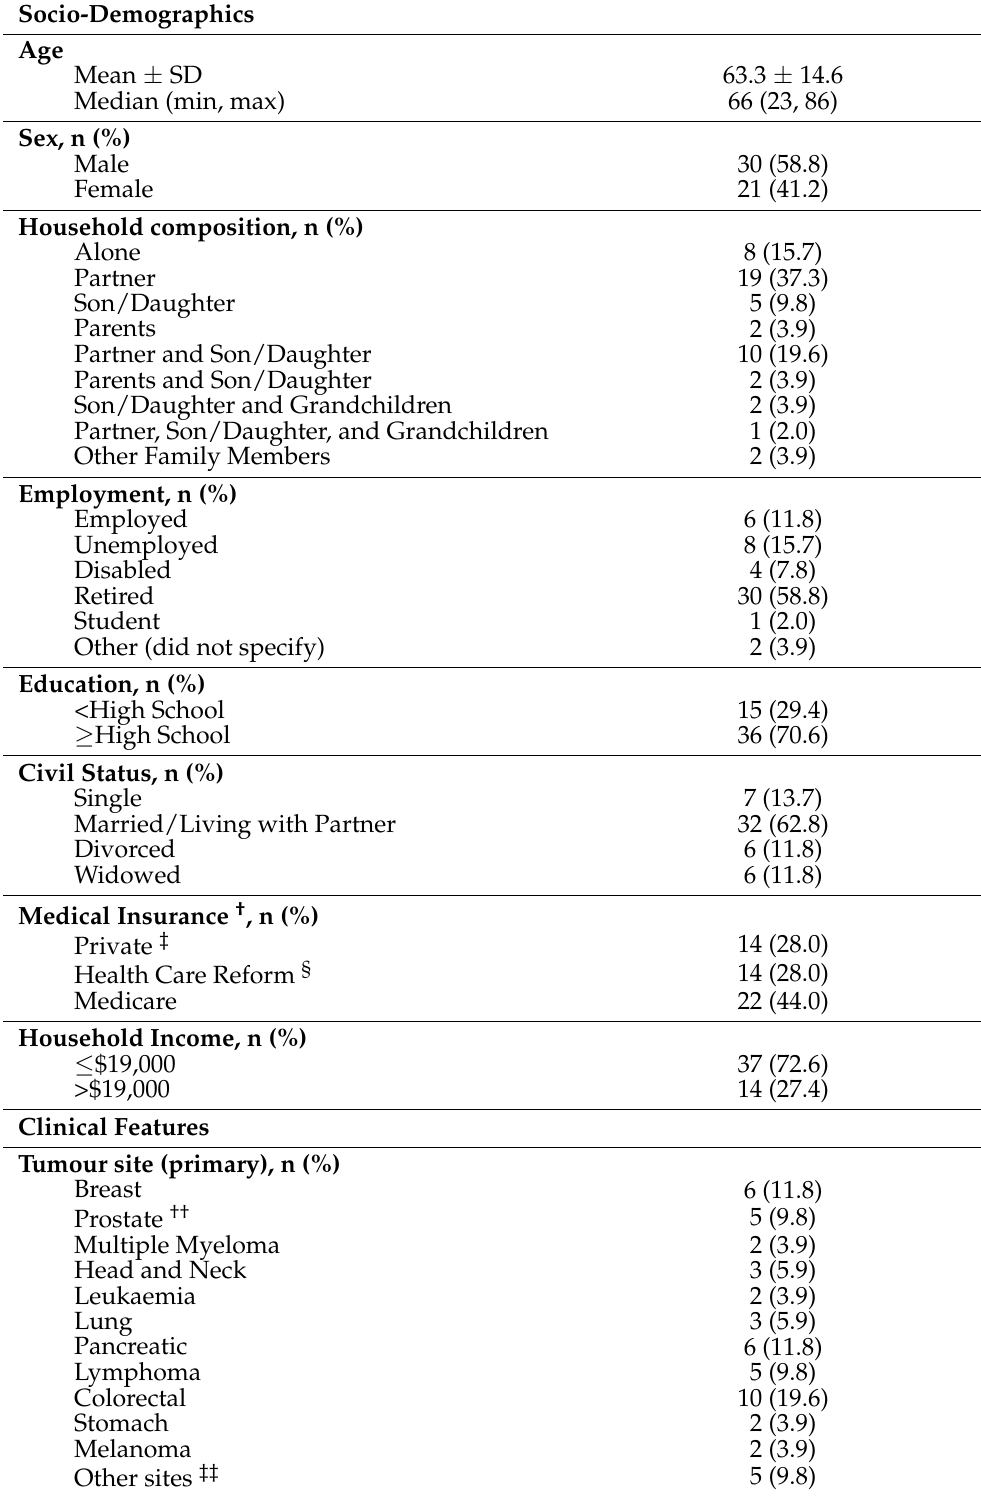
Table 1. Socio-demographics and clinical features of participants (n =